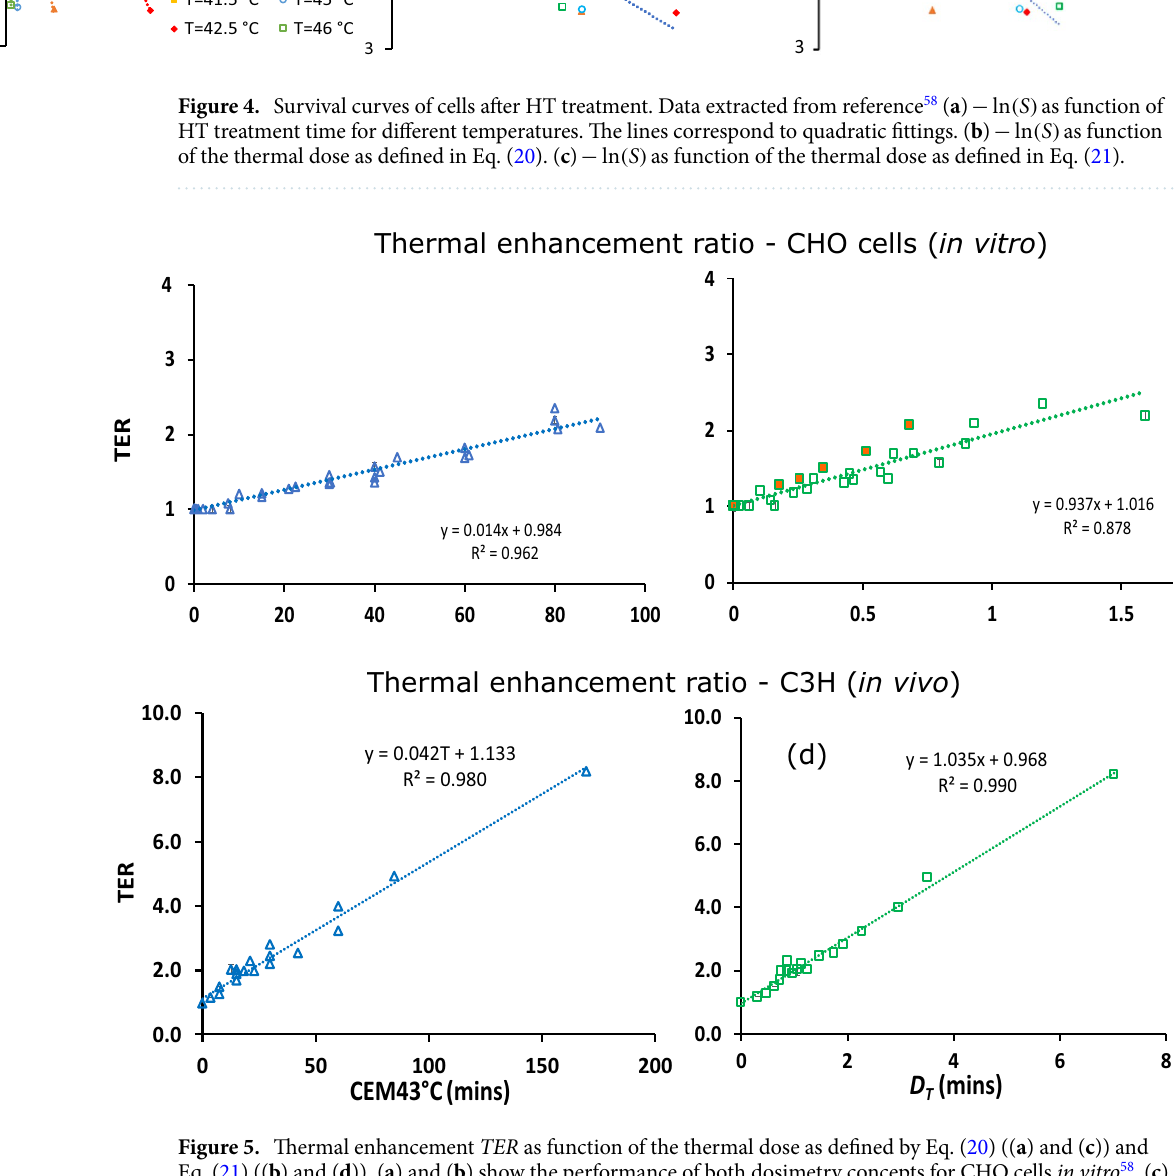
Figure 5. Thermal enhancement TER as function of the thermal dose as defined by Eq. (20) (( a ) and ( c )) and Eq. (21) (( b ) and ( d )). ( a ) and ( b ) show the performance of both dosimetry concepts for CHO cells in vitro 58 . ( c ) and ( d ) show the performance for C3H mammary carcinoma cells in mice tumours in vivo 60 . The filled (orange) symbols in ( b ) correspond to the TERs obtained at 43